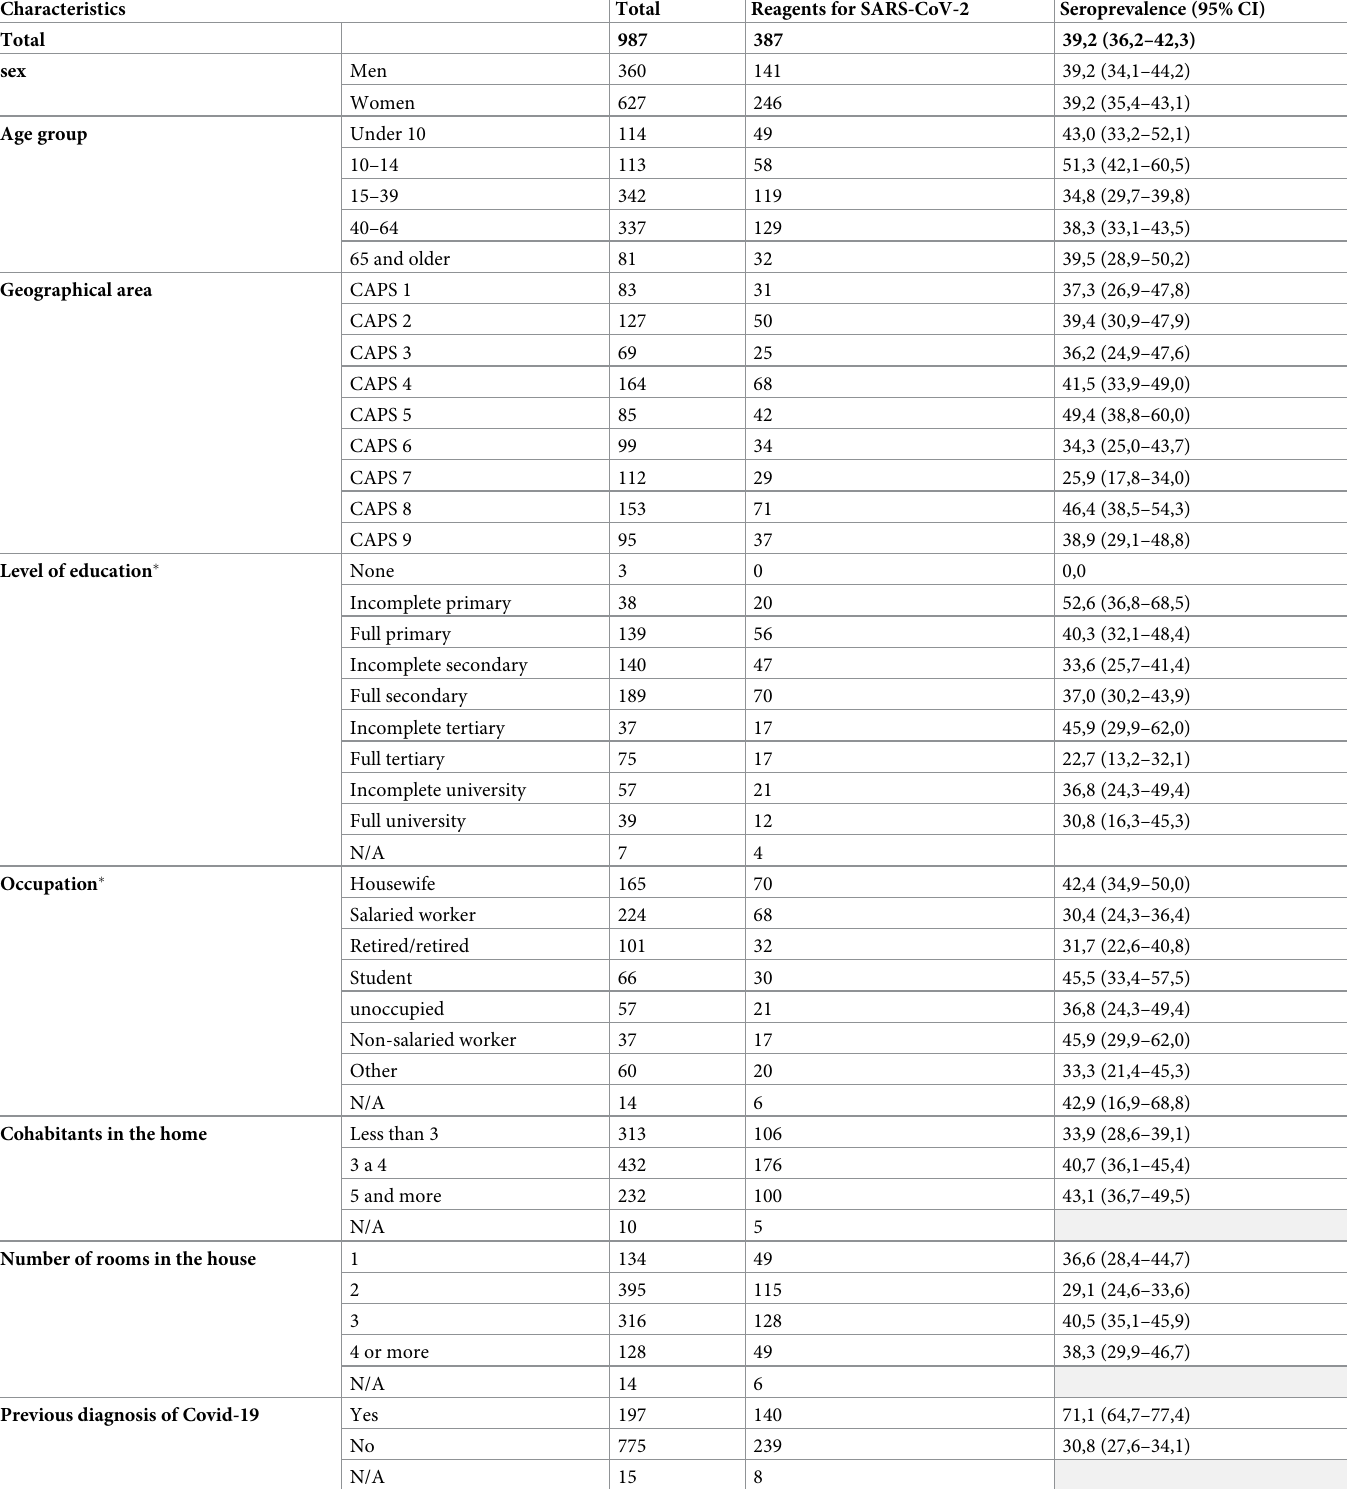
Table 2. COVID-19 seroprevalence in the Puerto Madryn population studied.